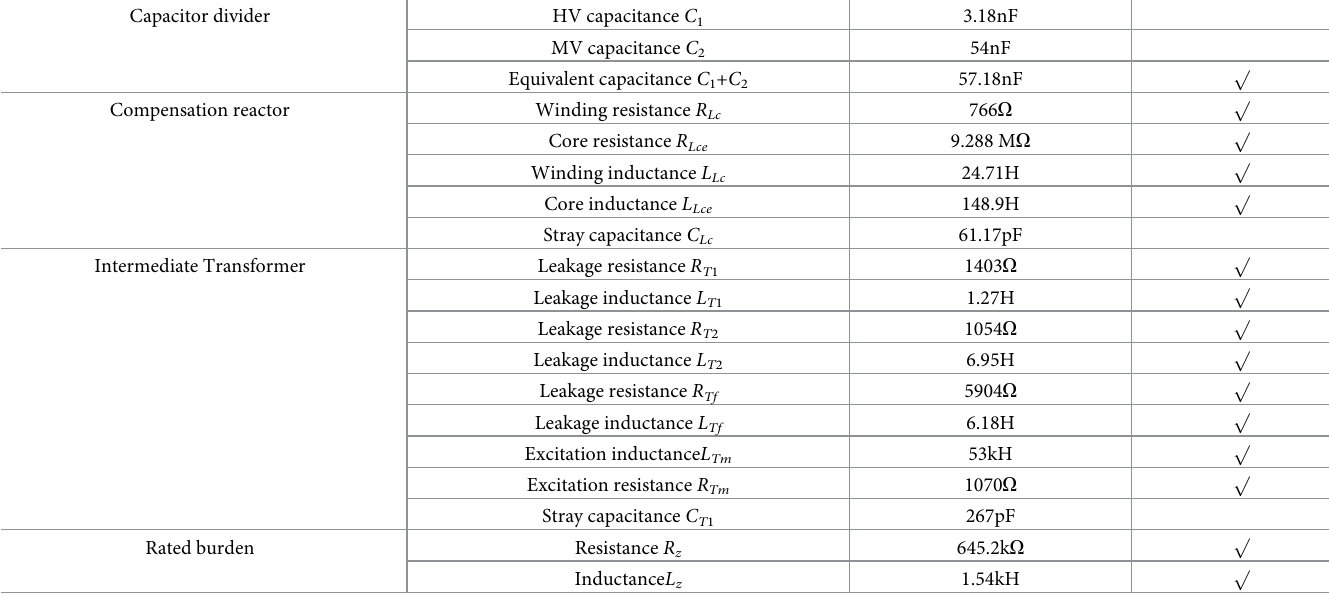
Table 1. Parameter values of the common elements of the two